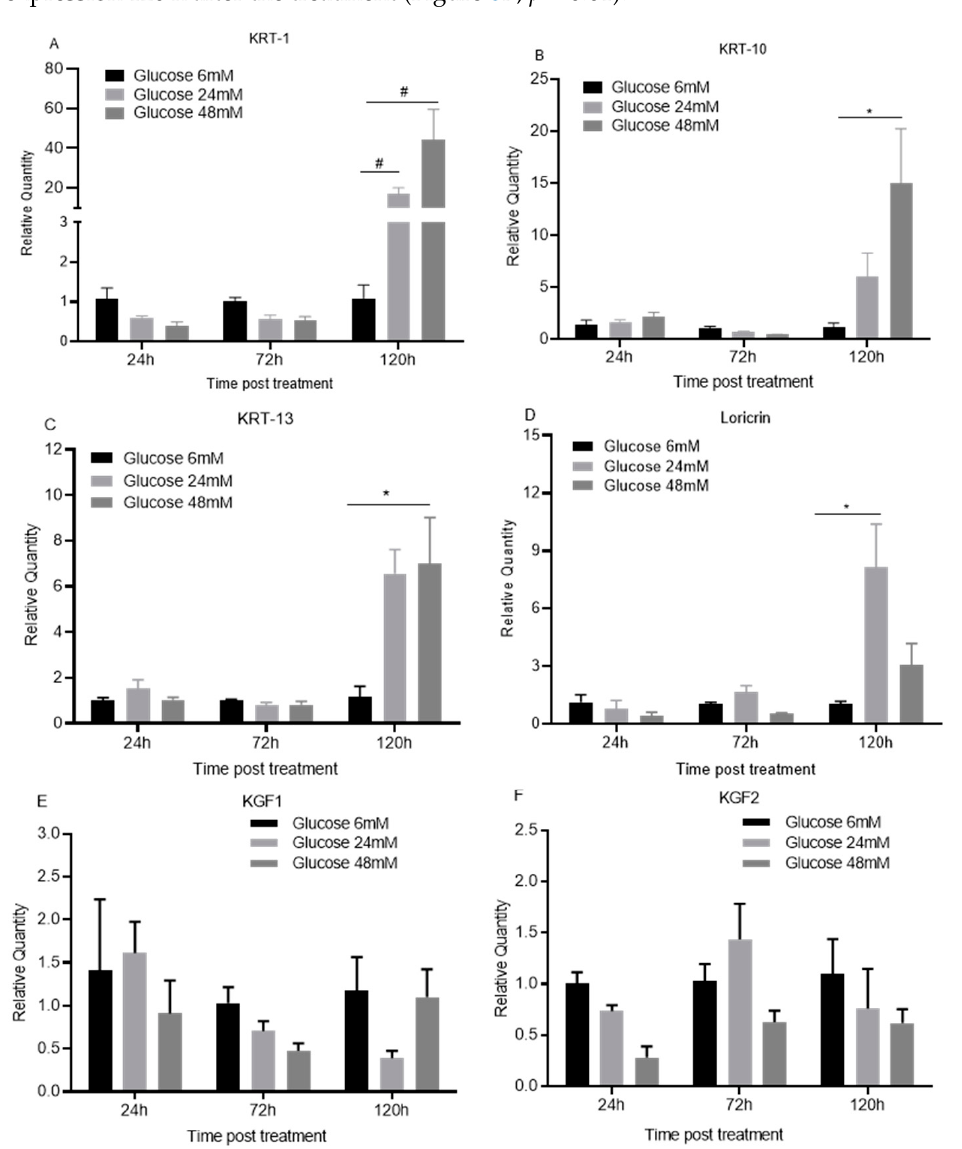
Figure 5. High glucose upregulates late differentiation markers in oral keratinocytes. TIGK cells treated with different concentrations of glucose (6, 24, 48 mM) were harvested. Total RNAs were extracted and cDNAs were prepared. Real-time PCR was performed to detect the mRNA expression of KRT-1 ( A ), KRT-10 ( B ), KRT-13 ( C ), loricrin ( D ), KGF1 ( E ) and KGF2 ( F ). There were 3 replicates at each culture condition and each time point. The expression of the targets in the cells with 6 mM treatment at each time point was used as the baseline. * p < 0.05, # p < 0.01. One-way ANOVA followed by Tukey’s post-tests was used for statistical